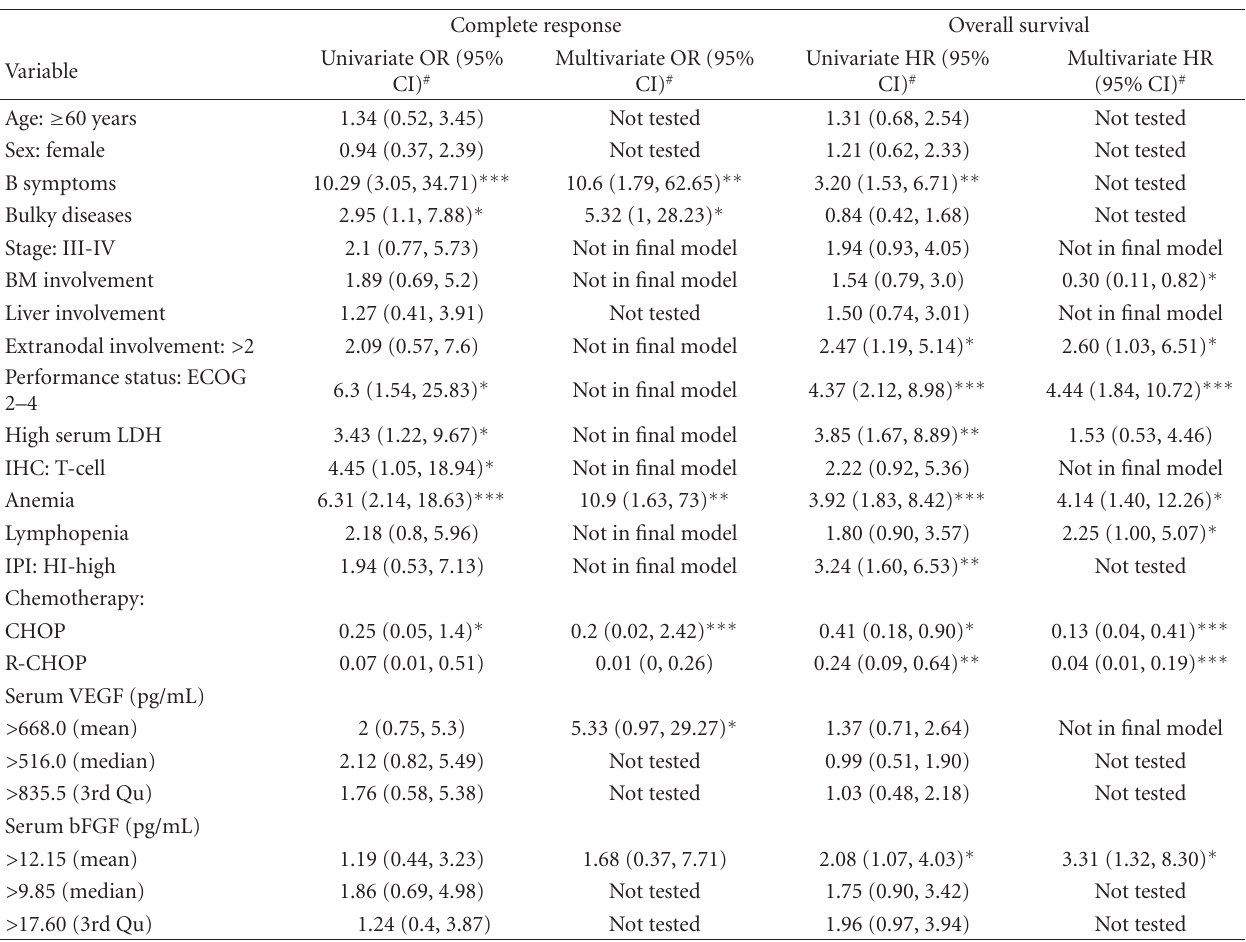
Table 2: Univariate and multivariate analysis for complete response and overall